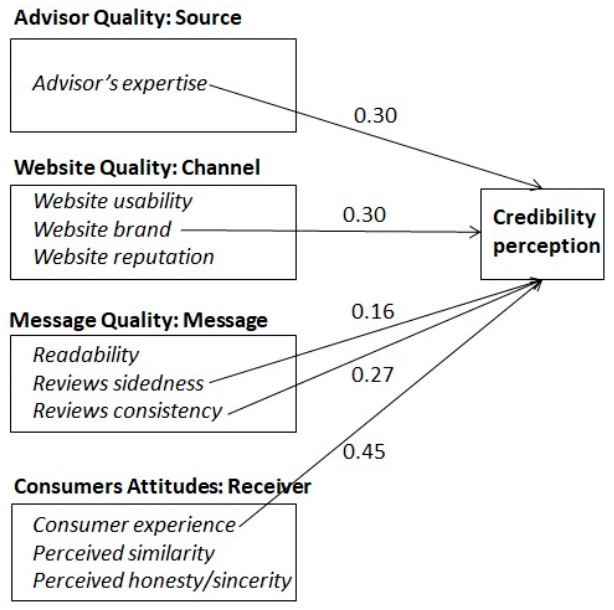
Figure 6. CONsumers’ Credibility percEPTion (CONCEPT) model.